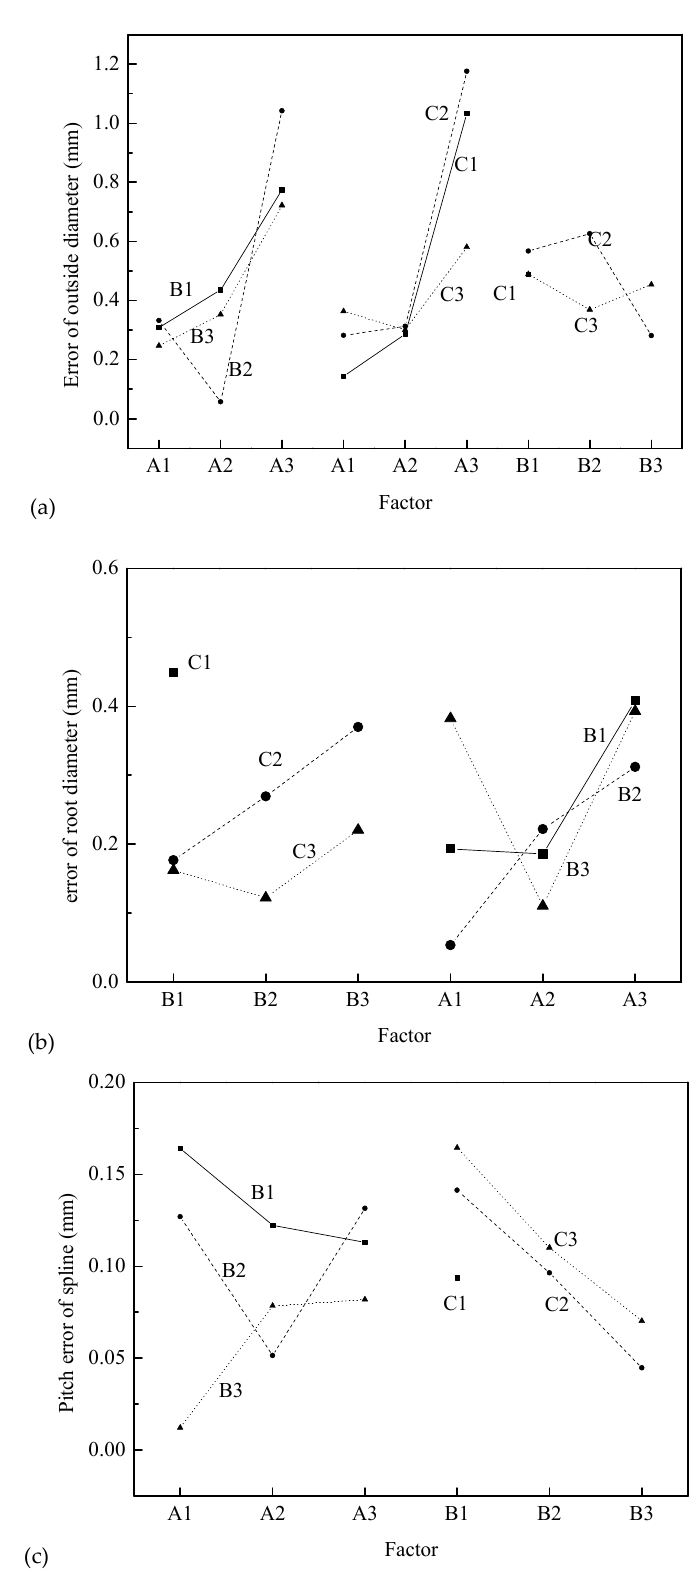
Figure 16. Interactions among factors for the error of geometrical parameters of splined section: ( a ) error of outside diameter, ( b ) error of root diameter, ( c ) pitch error of spline.